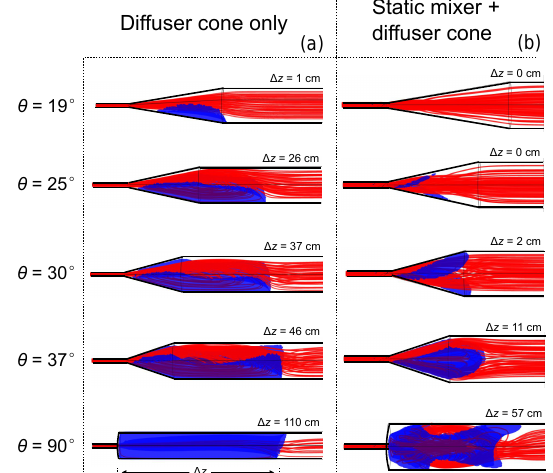
Figure 5. COMSOL simulation results for a suite of diffuser angles assuming isothermal conditions. Images in the left column are from simulations conducted in the absence of a static mixer. Images in the right column are from simulations employing a two-element static mixer upstream of the diffuser cone. The red traces are streamlines demonstrating the flow pattern of fluid introduced upstream of the static mixer. The blue surfaces illustrate regions where the axial ve- locity < 0ms − 1 . Together, these traces illustrate the recirculation zone. (cid:49)z is the length that the recirculation zone penetrates into the reaction section. All simulations were performed for a volumetric reactor flow of 2Lmin − 1